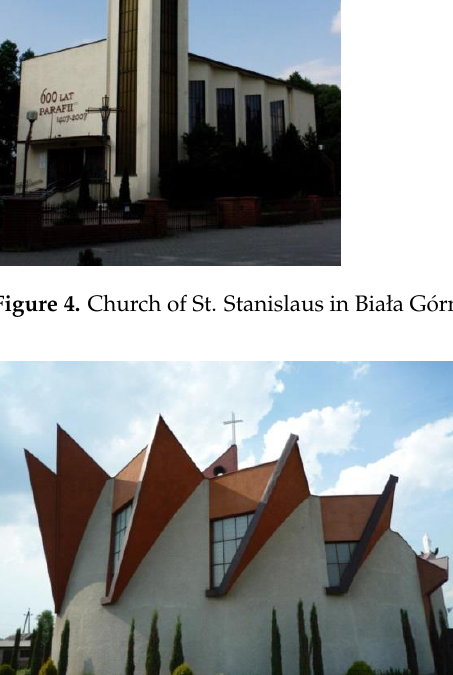
Figure 5. Church of St. Maksymilian Maria Kolbe in Kuleje (built in 1985–90).